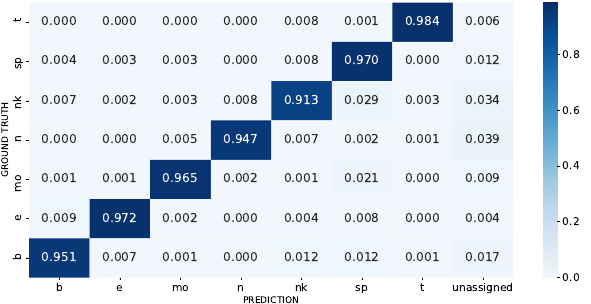
Figure 6. The aggregated cross-validation confusion matrix of the Immune dataset. The cell types b, e, mo, n, nk, sp, and t refer to B cells, erythrocytes, monocytes, neutrophils, NK cells, CD34+ HSPCs, and T cells, respectively. The unassigned label refers to cells that the model that could not correctly assign a known cell type.